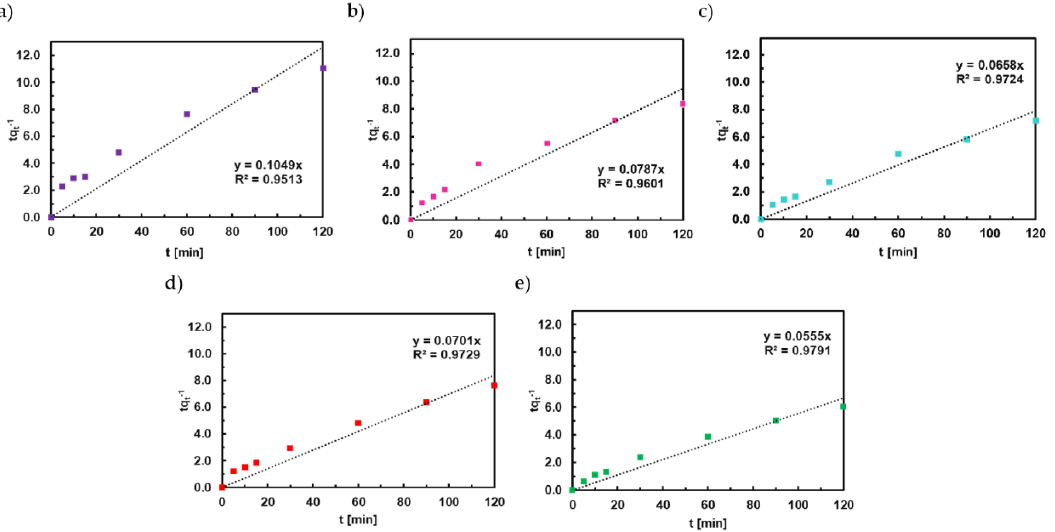
Figure 16. Adsorption data modeled using kinetic Lagergren’s pseudo-first-order law for ( a ) Fe 3 O 4 ,